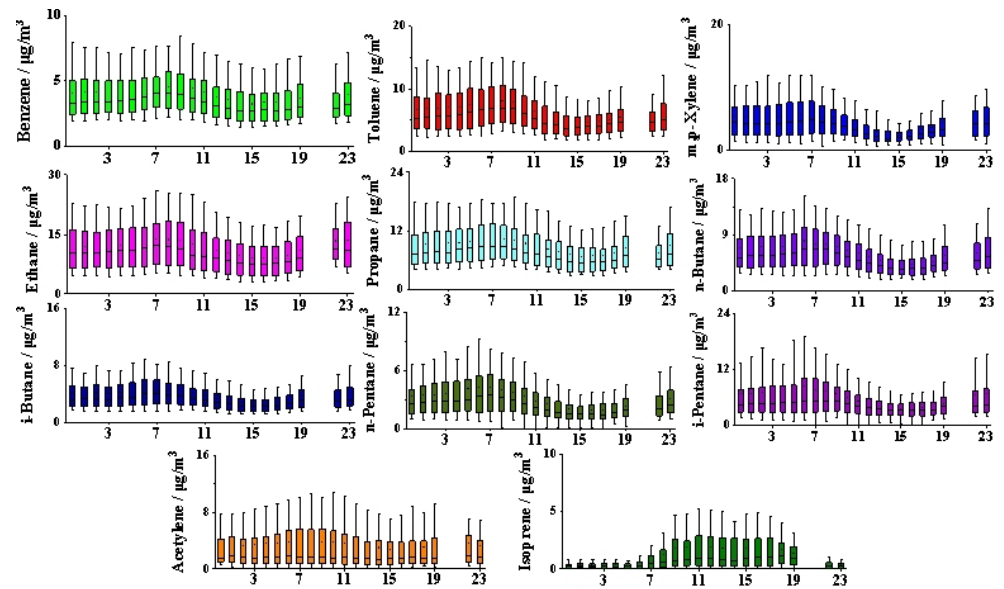
Figure 3. Diurnal variations in VOCs compounds measured at Zhengzhou. The upper and lower boundaries of the boxes indicate the 75th and 25th percentiles, respectively; the lines within the boxes mark the median; the whiskers above and below the boxes indicate the 90th and 10th percentiles, respectively.